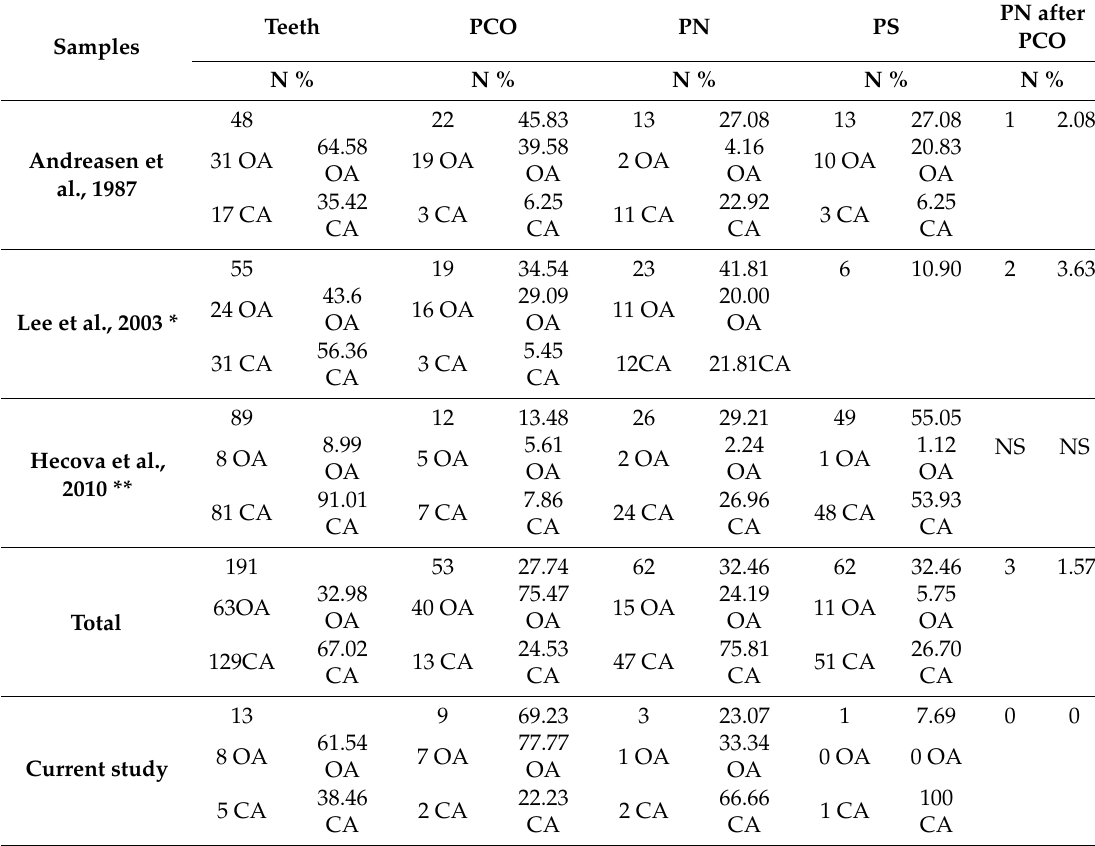
Table 6. The table shows the comparison of pulp consequence data with literature